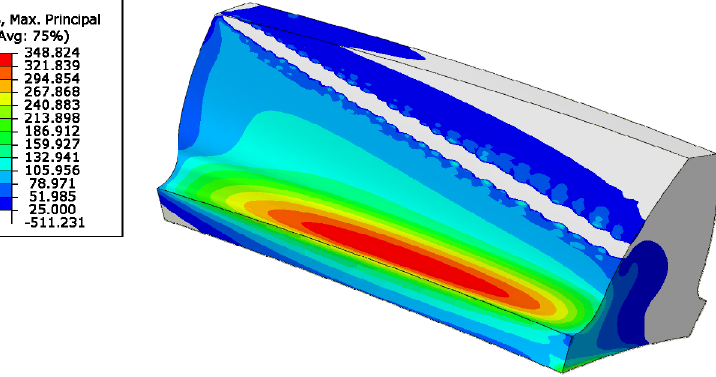
Figure 8. Example of main model FE results showing the maximum principal stress (Modified Geometry).